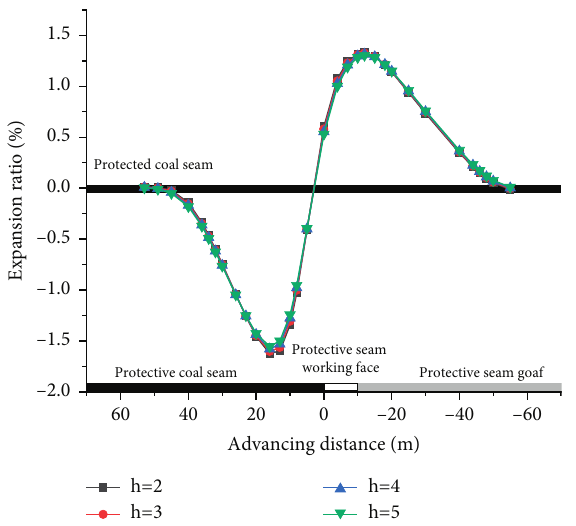
Figure 9: Variation curve of expansion rate of different coal thicknesses in the protected layer.